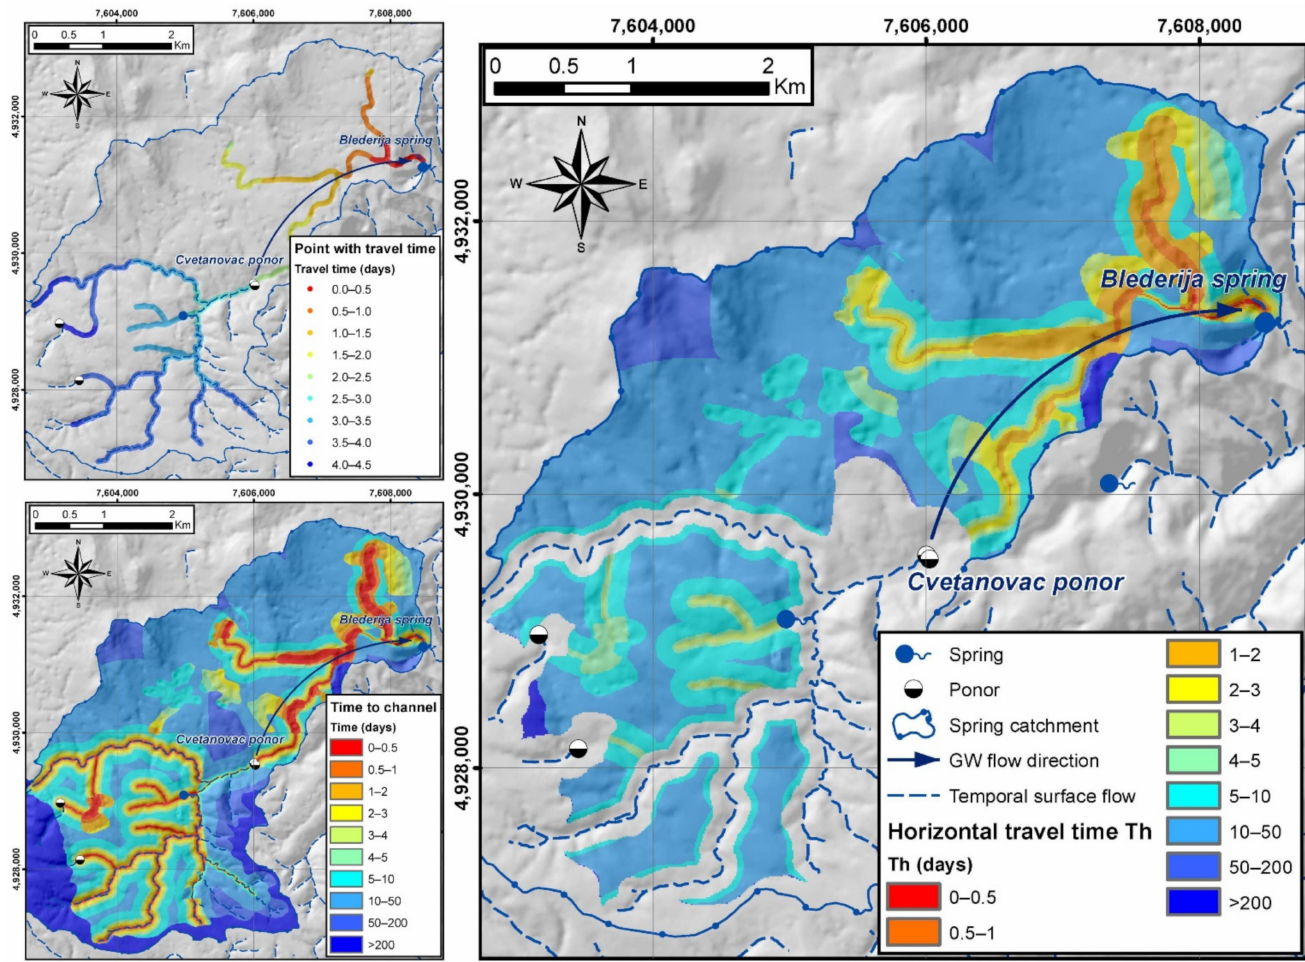
Figure 8. Horizontal travel time (t h ) through the saturated